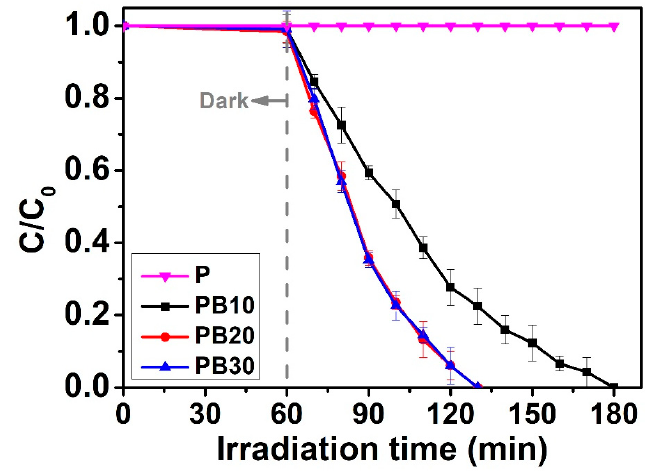
Figure 11. Photodegradation curves of RhB over polymer-modified gauze (P), and polymer/BiOBr- modified gauze samples (PB10, PB20, PB30).